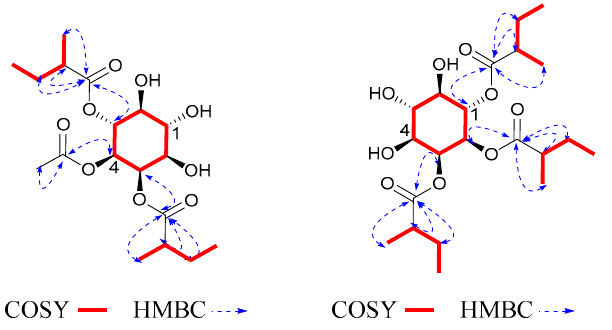
Figure 6. 1 H- 1 H COSY, key HMBC correlations of compounds 7 and 8 . Compound 8 was obtained as a colorless solid. Its molecular formula, C 21 H 36 O 9 , was determined by positive HR-ESI-MS at m / z 450.2715 [M + NH 4 ] + (calcd. 450.2703) with four degrees of unsaturation. 1 H and 13 C NMR spectra were close to compound 1 with the presence of one cyclohexane structure. The main difference was the substituent pattern and number. In 1 H- 1 H COSY and HMBC (Figure 6) spectra, the correlation from H-2 to C-2MB indicated that the 2MB was attached to C-2; the correlation from H-3 to C-2MB ′ indicated that the 2MB ′ was attached to C-3; the correlation from H-4 to C-2MB ″ indicated that the 2MB ″ was attached to C-4. The coupling patterns of six oxygenated methine protons were close to 1 . Therefore, compound 8 was myoinositol-2,3,6-(2-methylbutyrate), and was named solsurinositol H. Using the CCK8 method, the in vitro cytotoxicity of all isolated compounds on BV2 cells was evaluated in vitro. The results are listed in Table 3. Compounds 1 – 8 were not significantly cytotoxic to BV2 cells (IC 50 > 100 µM).